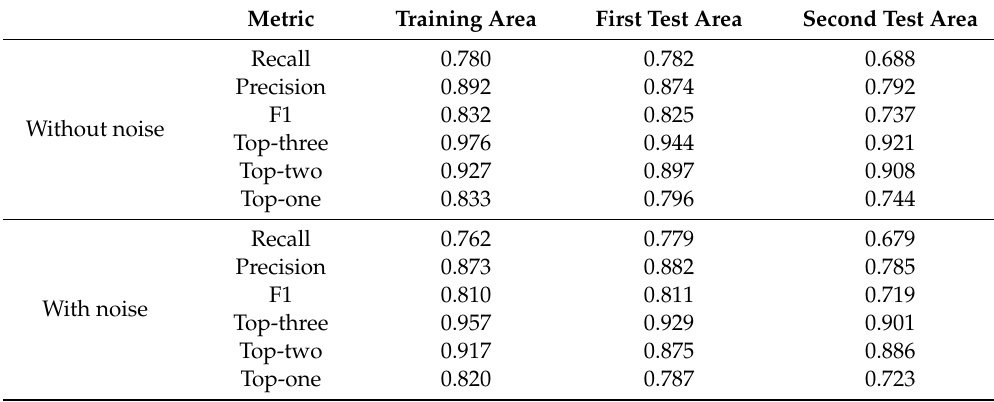
Table 11. Impact of Gaussian noise (mu = 0, sigma =